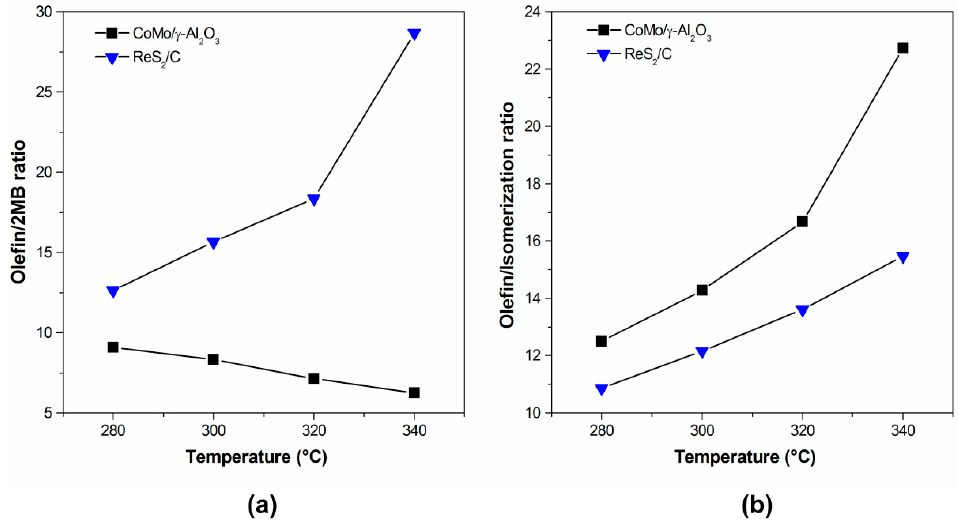
Figure 7. ( a ) Olefin/isomerization and ( b ) Olefin/2MB ratios versus the reaction temperature.